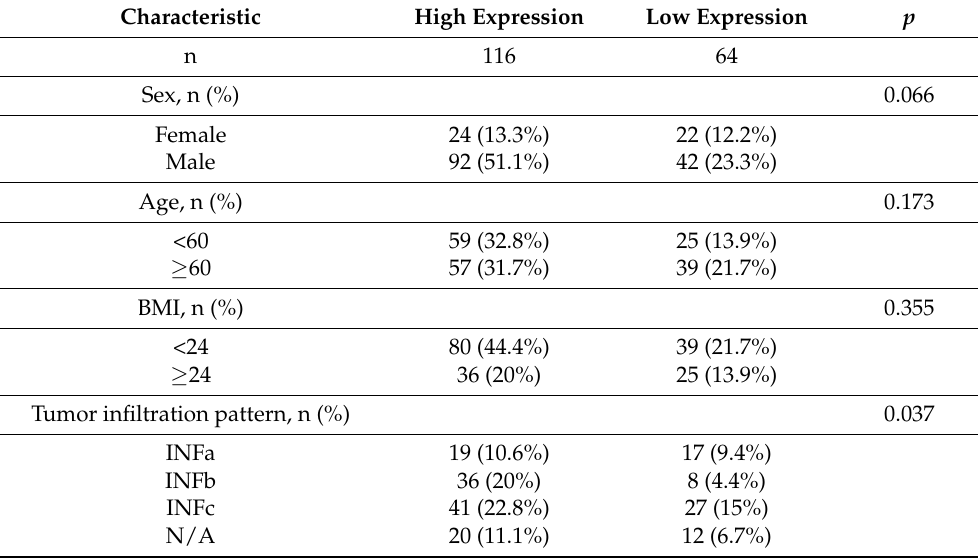
Table 3. Relationship between FBLN5 mRNA expression and clinical features of GC